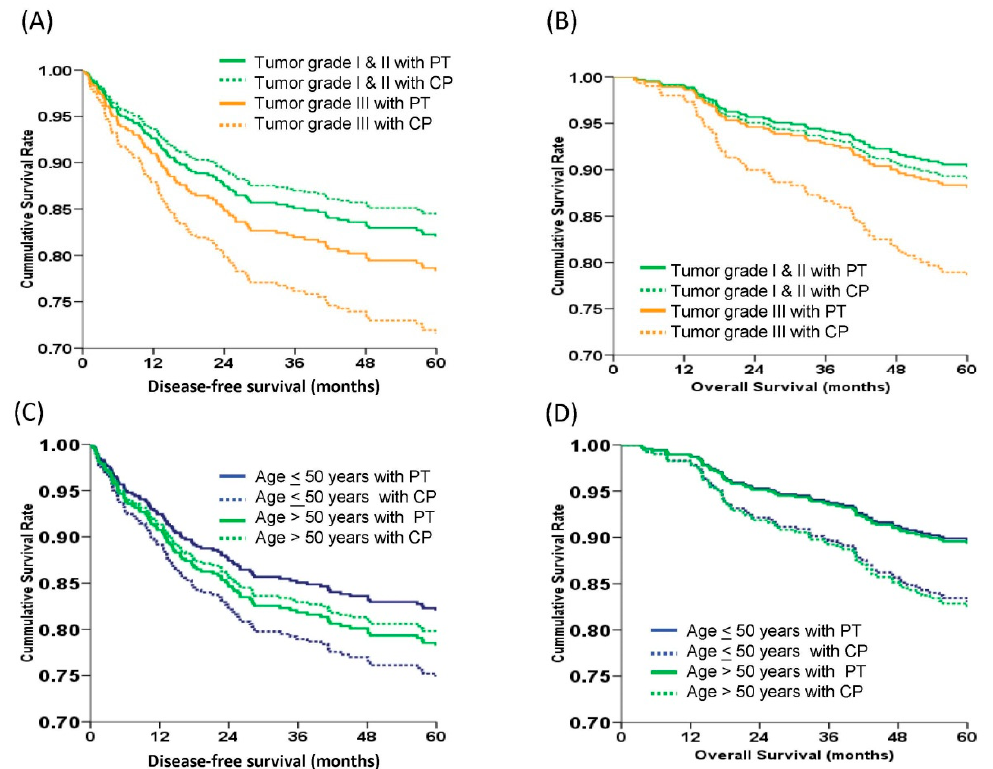
Figure 3. The survival curves of 437 early stage epithelial ovarian carcinoma women stratified by chemotherapeutic regimens and tumor grade or chemotherapeutic regimens and age at diagnosis by multivariate Cox regression models. ( A ) Estimated 5-year disease-free survival (DFS) curves. There was no difference in the 5-year DFS of different tumor grades between PT or CP regimens (grade 1/2 82.0% vs. 84.5%, aHR = 0.70, 95% CI = 0.18–2.63, p = 0.675; grade 3 78.4% vs. 72.3%, aHR = 0.73, 95% CI = 0.44–1.21, p = 0.224). ( B ) Estimated 5-year overall survival (OS) curves. The 5-year OS rate of patients with grade 3 tumors treated with PT regimens was higher than those treated with CP regimens (87.2% vs. 78.9%, aHR = 0.52, 95% CI = 0.28–0.95, p=0.034). However, the 5-year OS was not different between PT and CP regimens in grade 1/2 tumors (90.2% vs. 88.7%, p = 0.76). ( C ) Estimated 5-year disease-free survival (DFS) curves. There was no difference in the 5-year DFS between PT or CP regimens in the two age groups ( ≤ 50 years 82.3% vs. 74.9%, aHR 0.68, 95% CI = 0.38–1.22, p = 0.202; ≥ 50 years 78.2% vs. 79.5%, aHR 0.99, 95% CI = 0.55–1.78, p = 0.983). ( D ) Estimated 5-year overall survival (OS) curves. The 5-year OS rates of PT and CP were similar in both age groups ( ≤ 50 years, 89.8% vs. 82.9%, aHR 0.58, 95% CI = 0.29–1.18, p = 0.135; >50 years, 89.2% vs. 82.6%, aHR 0.60, 95% CI = 0.30–1.18, p = 0.141) (all by log-rank